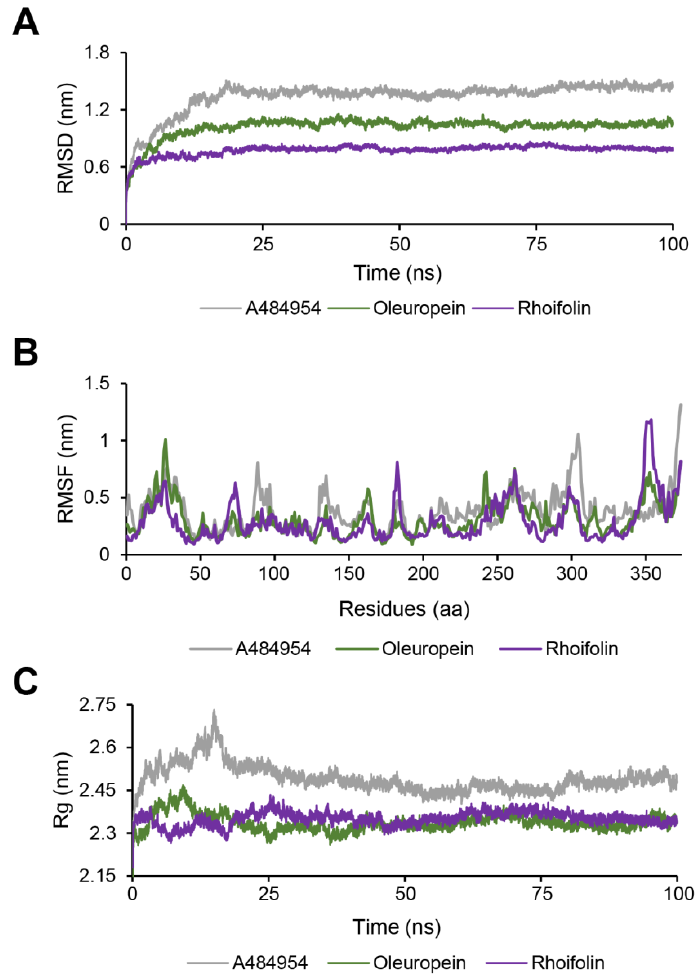
Figure 7. MD simulation analyses of eEF2K complexed to A484954, Oleuropein, and Rhoifolin. ( A ) RMSD values. ( B ) RMSF values. ( C ) Rg values. All analysis were performed with